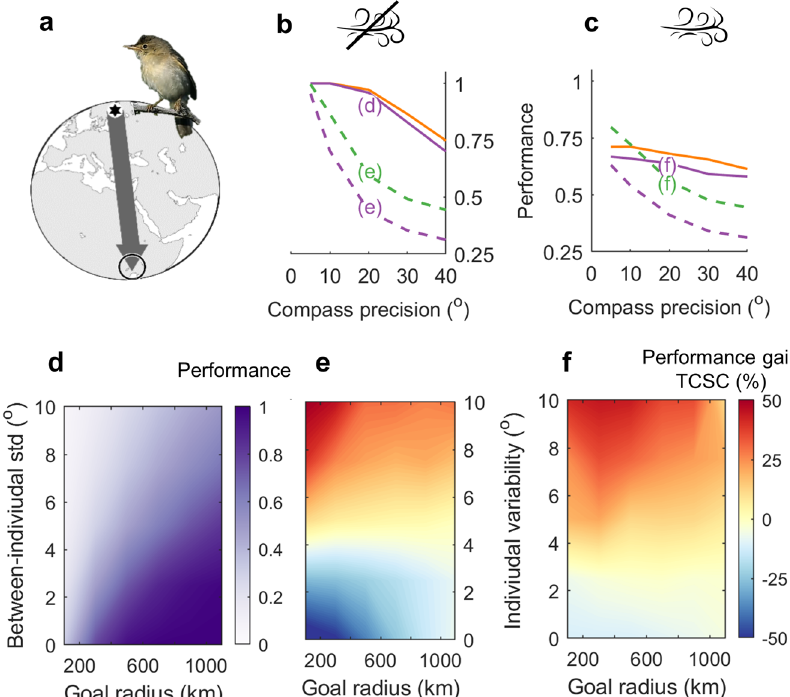
Fig. 6 Effects of in- fl ight drift, individual variability and goal area on predicted marsh warbler migration. a Marsh warbler ( Acrocephalus palustris ) migration route between breeding grounds in Finland and East Africa (grey arrow in stereographic map), with default 500-km goal radius (open circle). b Performance versus compass precision in the absence of drift for geomagnetic loxodromes (orange line), geographic loxodromes (purple line), cue- transferred geographic loxodromes (dashed purple line, when the star compass is unavailable on departure) and cue-transferred sun compass courses (dashed green line). c As in b , except with 20° within- fl ight drift. d Performance of geographical loxodromes (e.g., star compass) in the absence of drift as a function of goal radius and between-individual variability in inherited headings, based on 20° compass precision. e As in d , but depicting the relative performance gain with TCSC (%) over geographic loxodromes. f As in e , but with 20° within- fl ight drift. Photo by M. Szczepanek (https://